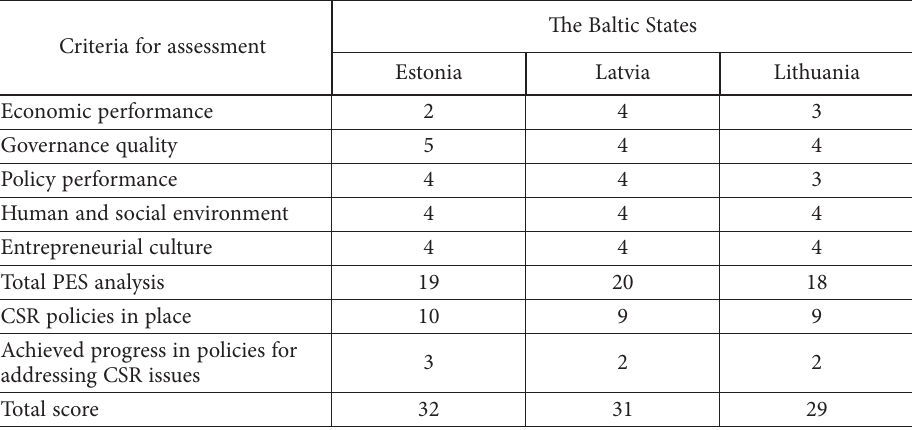
Table 5. The assessment of CSR performance in the Baltic States (source: created by the authors) Criteria for